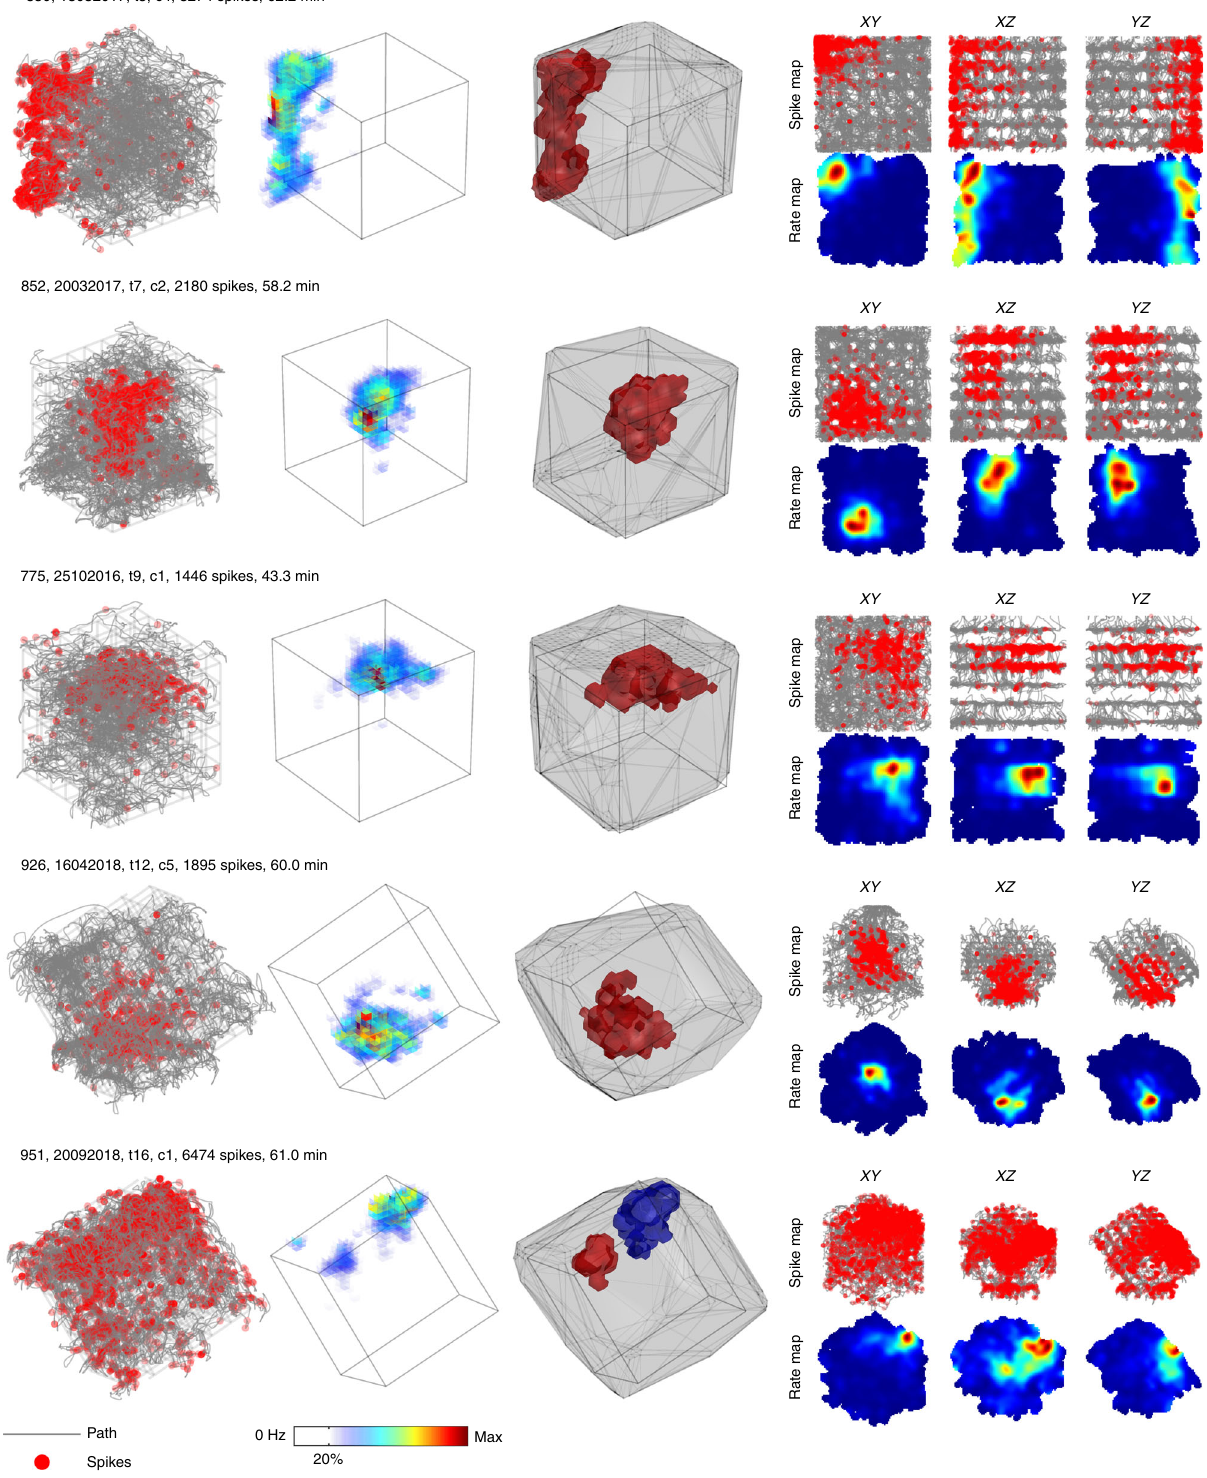
Fig. 3 Representative example place cells and their activity in the lattice mazes. For additional examples see Supplementary Figs. 3 and 4 and Supplementary Movies 1 and 2. Five cells are shown, one per row. First column shows the path of the animal and spikes plotted as red markers. Second column shows the three-dimensional fi ring rate map. Colors denote fi ring rate and areas of low or no fi ring are transparent. Third column shows the convex hull of the dwell time map as a gray outline and the convex hull of any detected place fi eld(s) as separate (color-coded) polygons. Last column shows the spike and fi ring rate maps when the data are projected onto the three possible cardinal